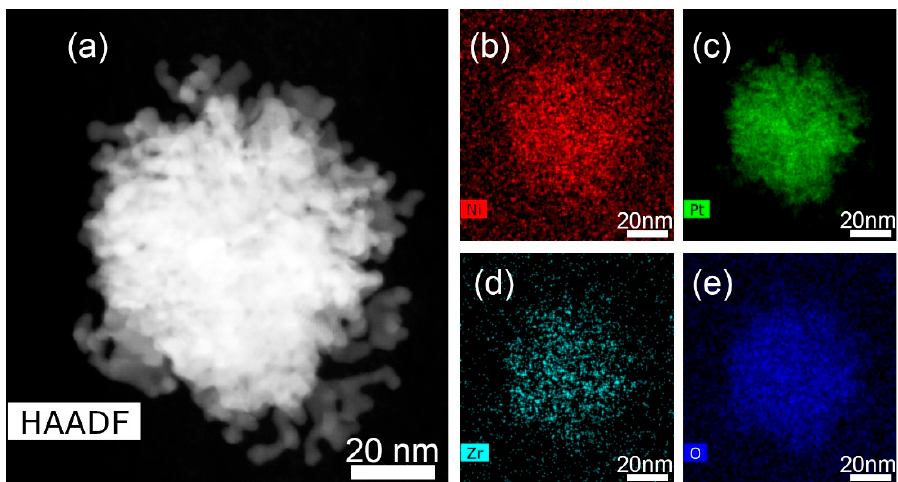
Figure 4. Elemental distribution in a platinum agglomerate: ( a ) STEM HAADF image of the agglom- erate; ( b )–( e ) corresponding elemental maps for sample 2 .